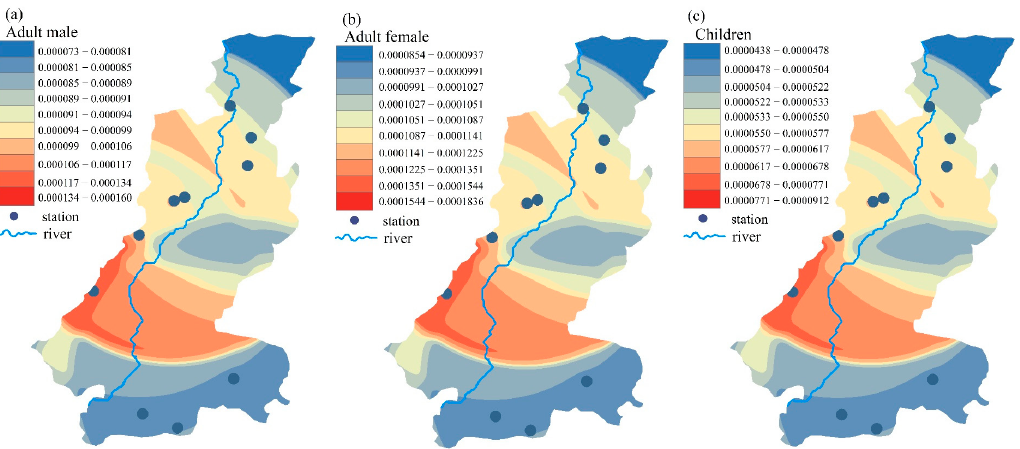
Figure 6. Spatial distribution of carcinogenic health risks for males ( a ), females ( b ), and children ( c